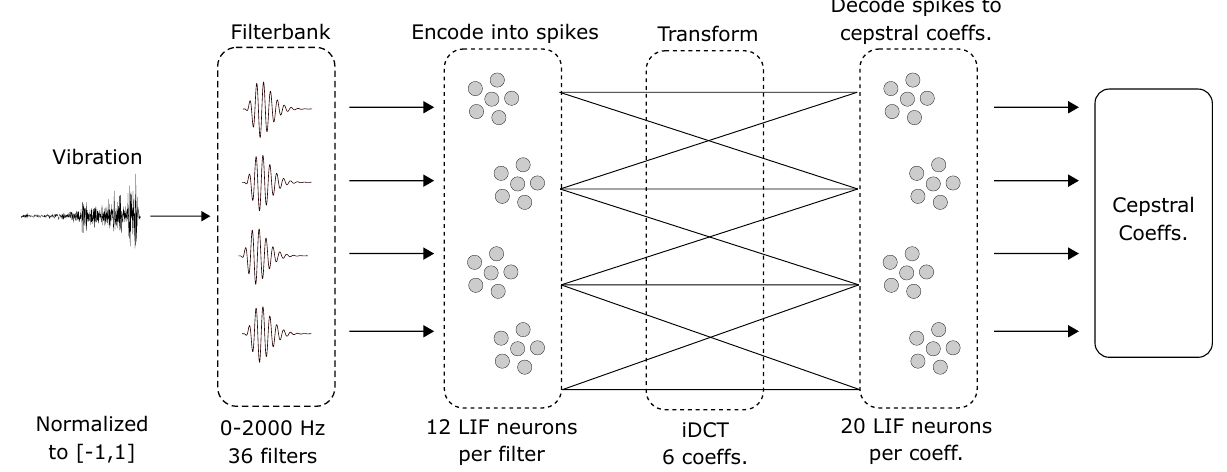
Figure 5. Schematic of the SNN architecture. The input signal is passed through filters with logarith- mically spaced characteristic frequencies and encoded into spikes. An ensemble of spiking neurons is allocated to each filter. The inverse DCT transformation is performed on the output of the first layer and passed to the second layer. The transformation is performed through weights on the connections between the layers. The cepstral coefficients are decoded from the second layer. The number of coefficients to be extracted is chosen such that the L2-norm of all the coefficients combined captures > 99% of the energy of the input signal. The number of ensembles is the same as the number of cepstral coefficients. The architecture is adapted from the Sermo model proposed by Bekolay